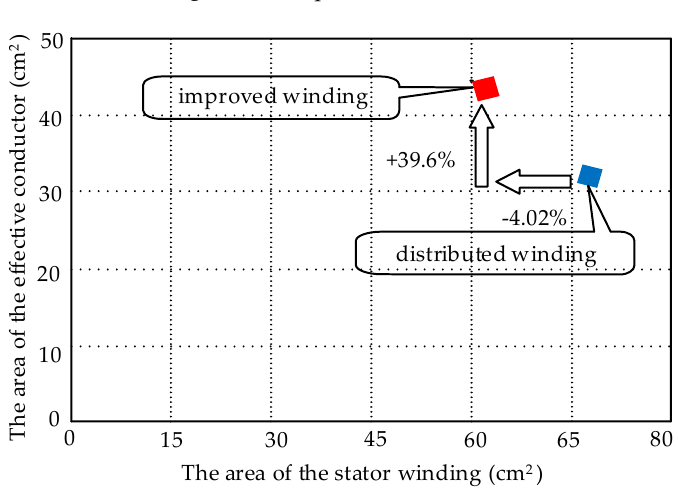
Figure 14. Comparison of both winding utilization ratios.